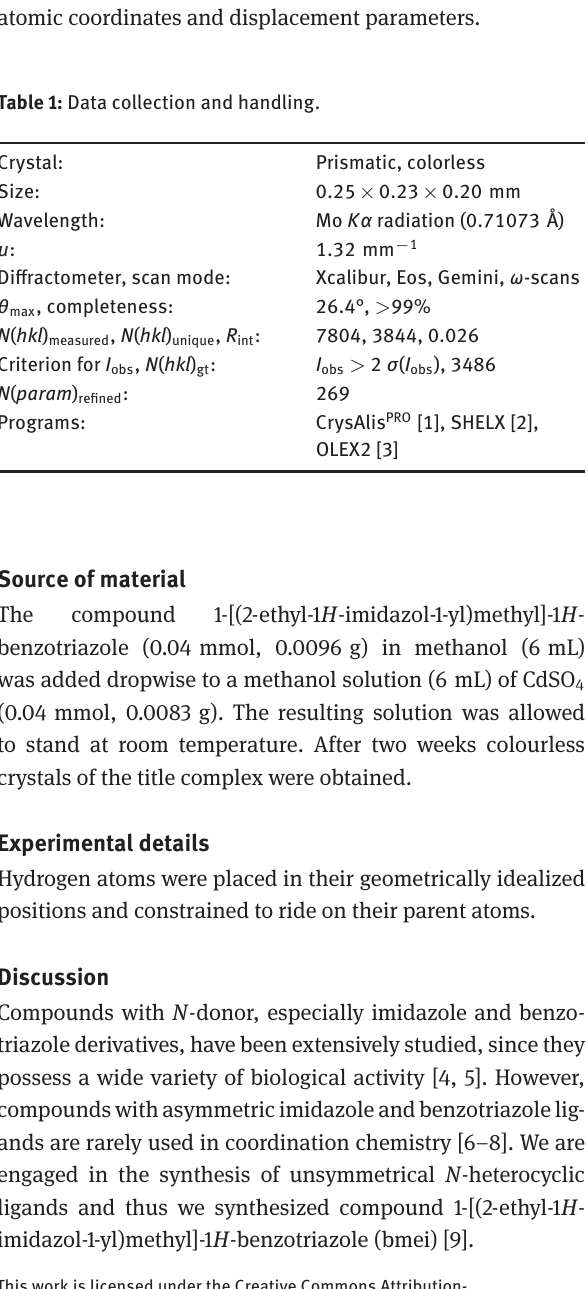
The crystal structure of the title complex is shown in the figure. Tables 1 and 2 contain details on crystal structure and measurement conditions and a list of the atoms including atomic coordinates and displacement parameters.